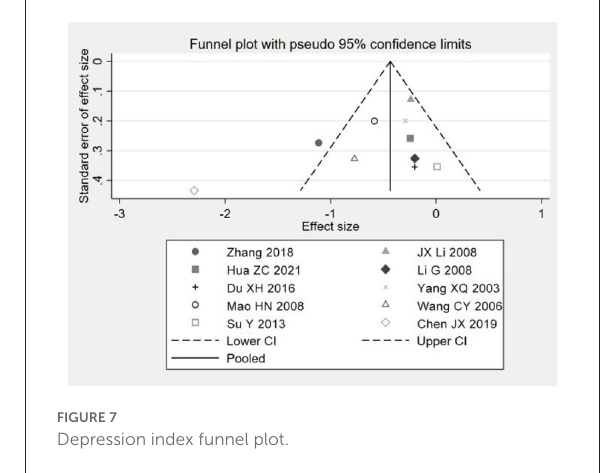
FIGURE7 Depression index funnel plot.